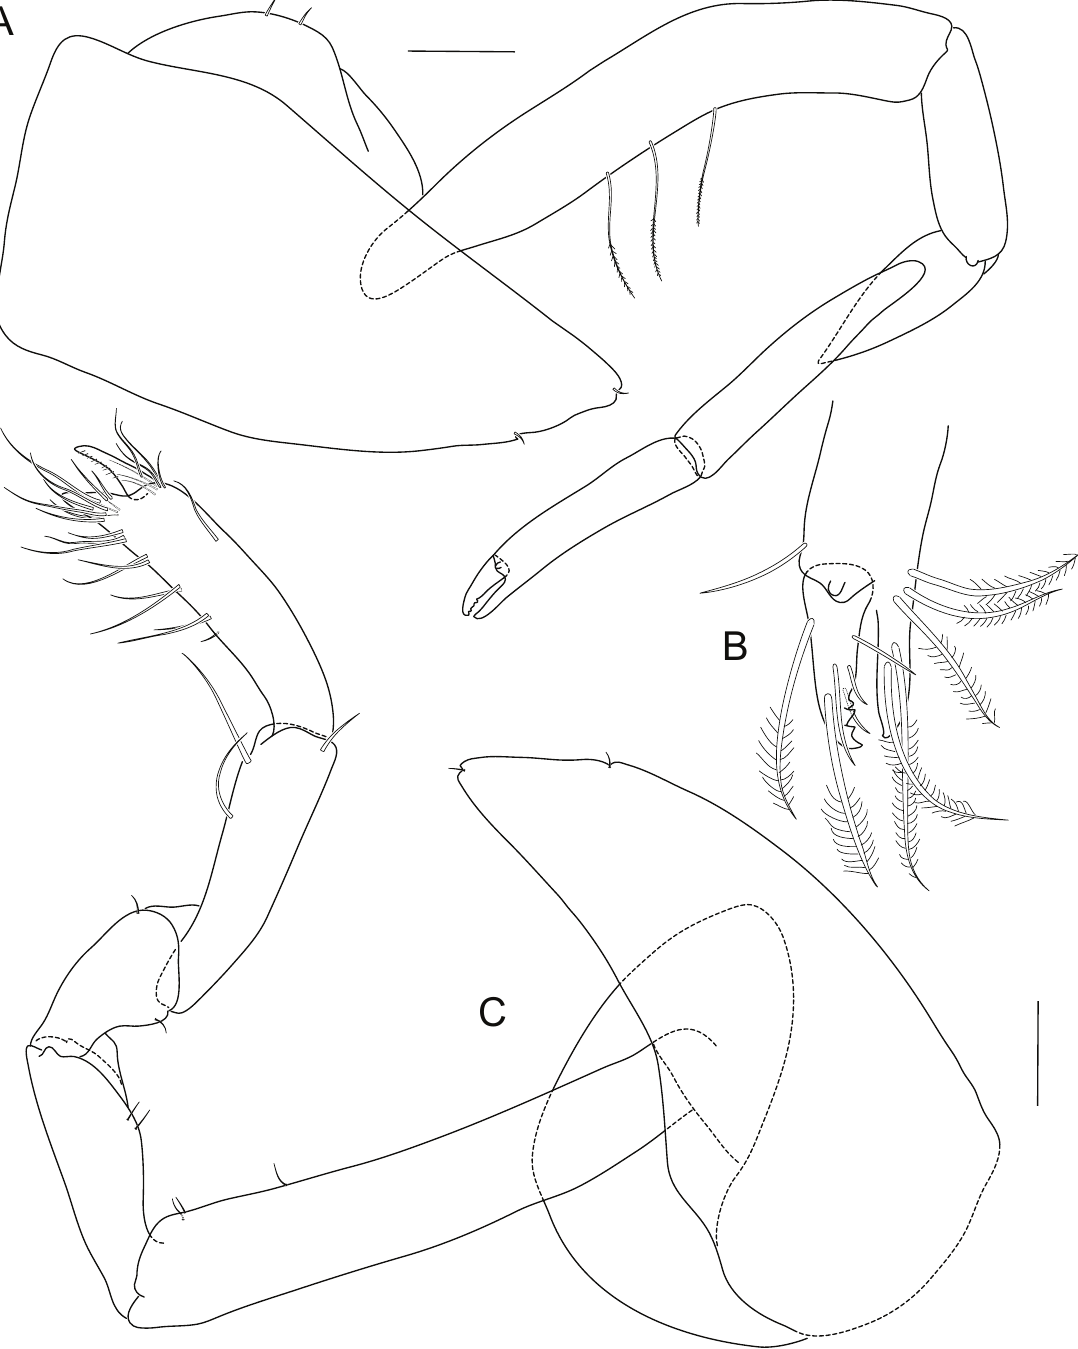
Fig. 4. Labriphimedia meikae nov. sp., holotype ♂, 6 mm, NIWA 84598. A . Gnathopod 1. B . Chela of gnathopod 1. C . Gnathopod 2. Scale bars: a, C = 100